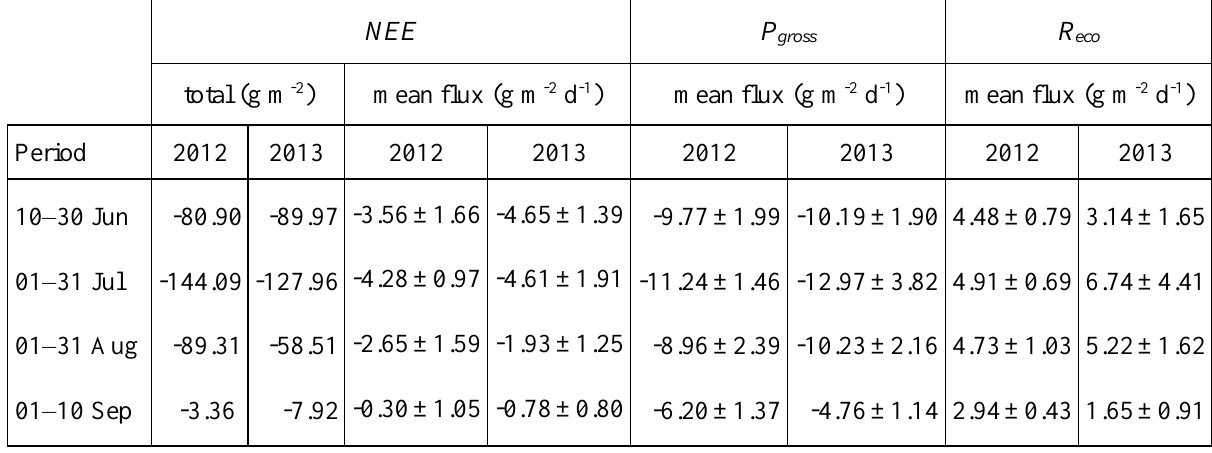
Table 2. Total NEE (g m -2 ) and mean CO measurement